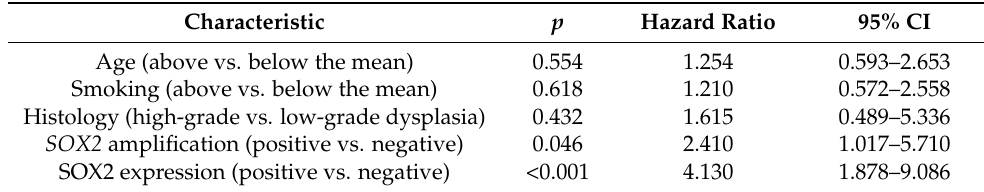
Table 2. Univariate Cox Proportional Hazards Model to Estimate Laryngeal Cancer Risk. Characteristic p Age (above vs. below the mean) Histology (high-grade vs. low-grade dysplasia) SOX2 amplification (positive vs. negative) SOX2 expression (positive vs.